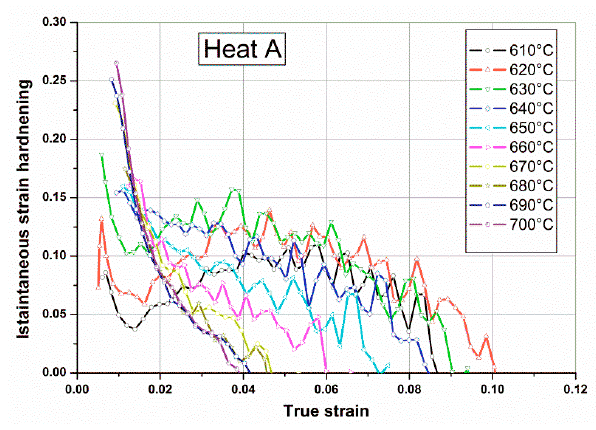
Figure 9. Instantaneous strain hardening coefficient of Heat A after different tempering treatments.